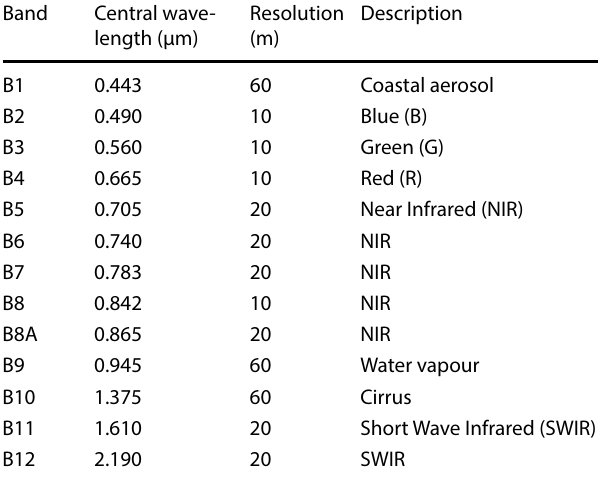
Table 1 Sentinel-2 multispectral bands [44] Band Central wave- length